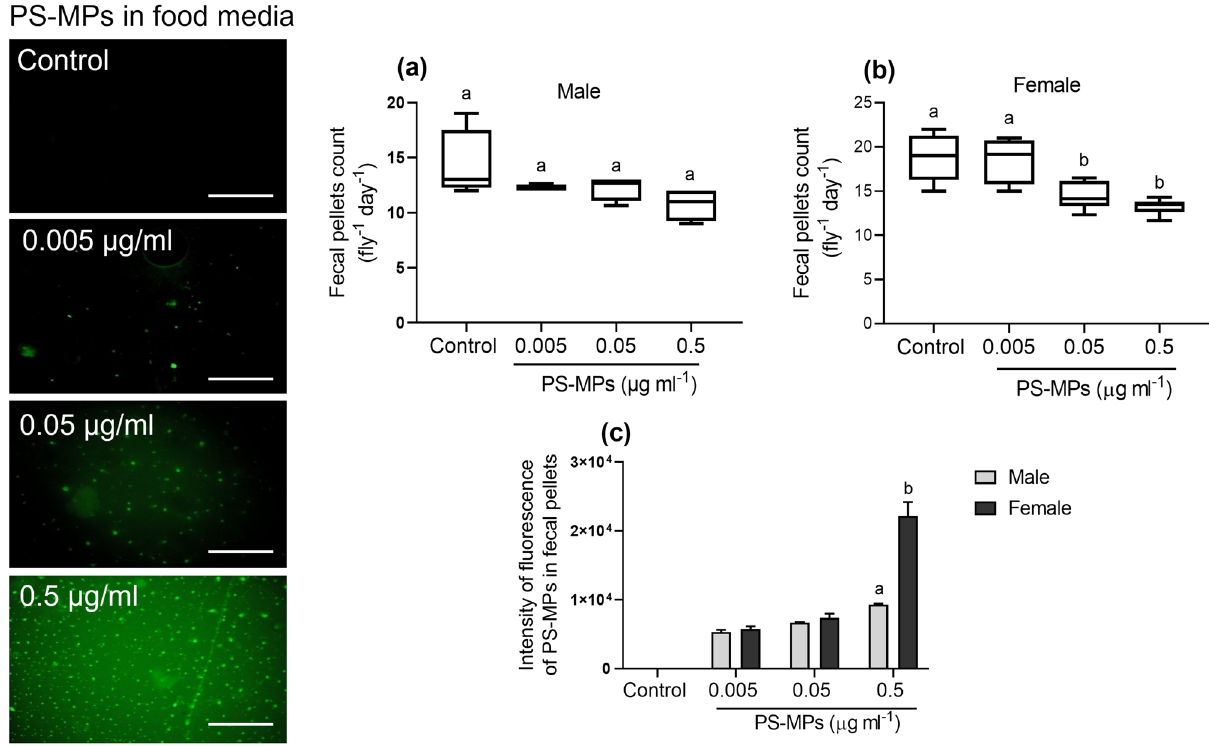
Figure 5. Showing polystyrene microplastics (PS-MPs) in food media (green dots) and the fecal pellets count of adult ( a ) male, ( b ) female flies (n = 5) fed food media either free of PS-MPs (control) or PS-MPs supplemented for 7-days and ( c ) integrated intensity of the fluorescence of PS-MPs in fecal pellets of both male and female flies. Symbols on the box plot represent maximum and minimum values (whiskers: ┬ ┴ ), mean values (-). Column bars (Mean ± SEM) and box plot with different lowercase letters denote significant differences among treatments (one-way ANOVA with Tukey post hoc test P < 0.05). Scale bar: 50